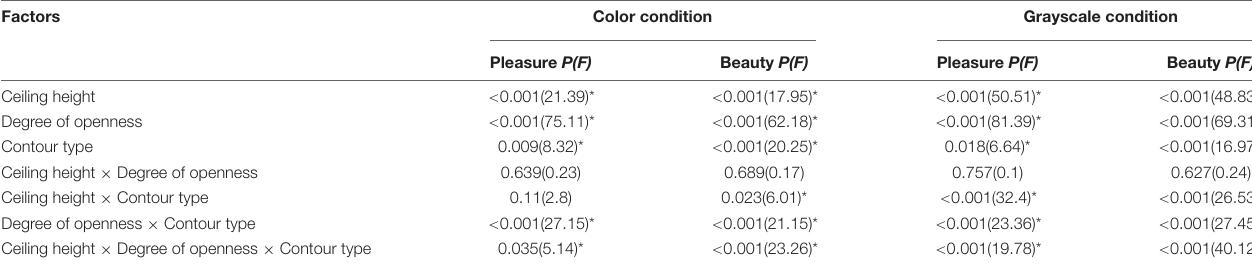
TABLE 1 | ANOVA analyses of the beauty ratings for the short viewing time condition and the grayscale condition.